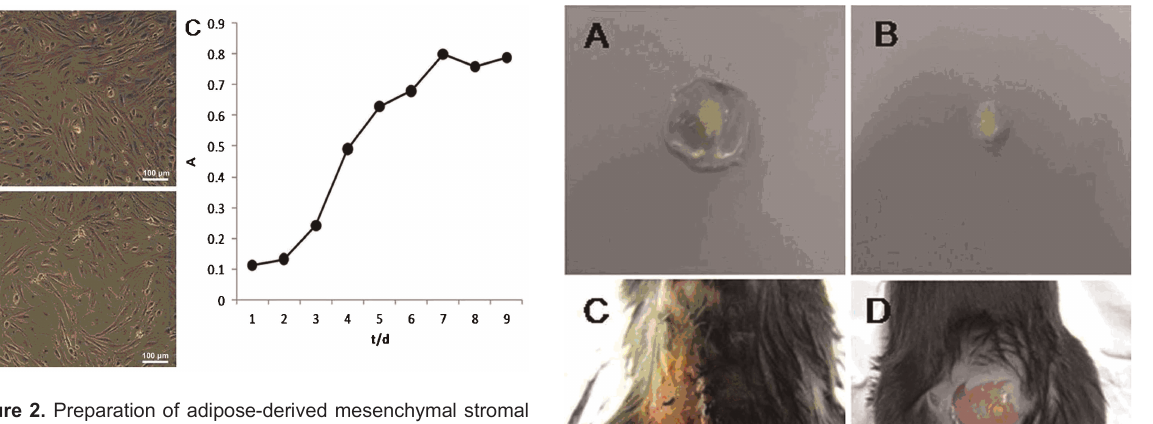
Figure 2. Preparation of adipose-derived mesenchymal stromal (ADMS) cells to manipulate the quasi-natural cell block. ADMS cells were isolated from peritoneal adipose tissue excised from the abdominal region of male C57BL/6 mice and cultured for in vitro expansion. Mouse ADMS cells at passage 2 ( A ) and passage 6 ( B ) showed similar fibroblast-like morphology. The growth curve of ADMS cells was determined at passage 6 by using the MTT assay ( C ); an initial lag phase of 2 days, a log phase from day 3 to day 5, and a plateau phase. Figure 3. In vitro construction and implantation of the quasi-